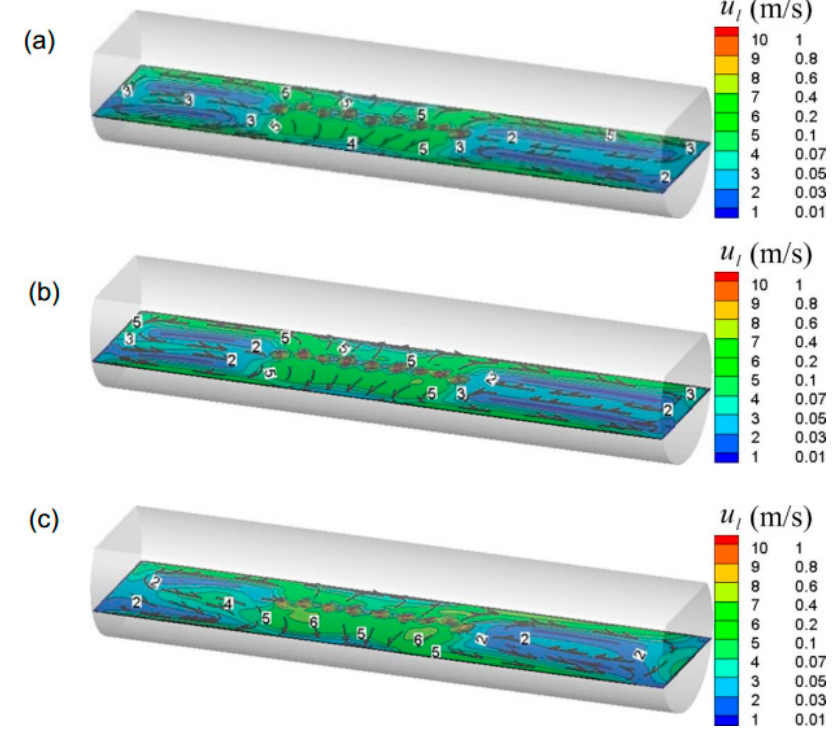
Figure 12. Predicted local liquid flow filed in the bath with different numbers of nozzles, which are ( a ) 9, ( b ) 13, and ( c ) 18, respectively.